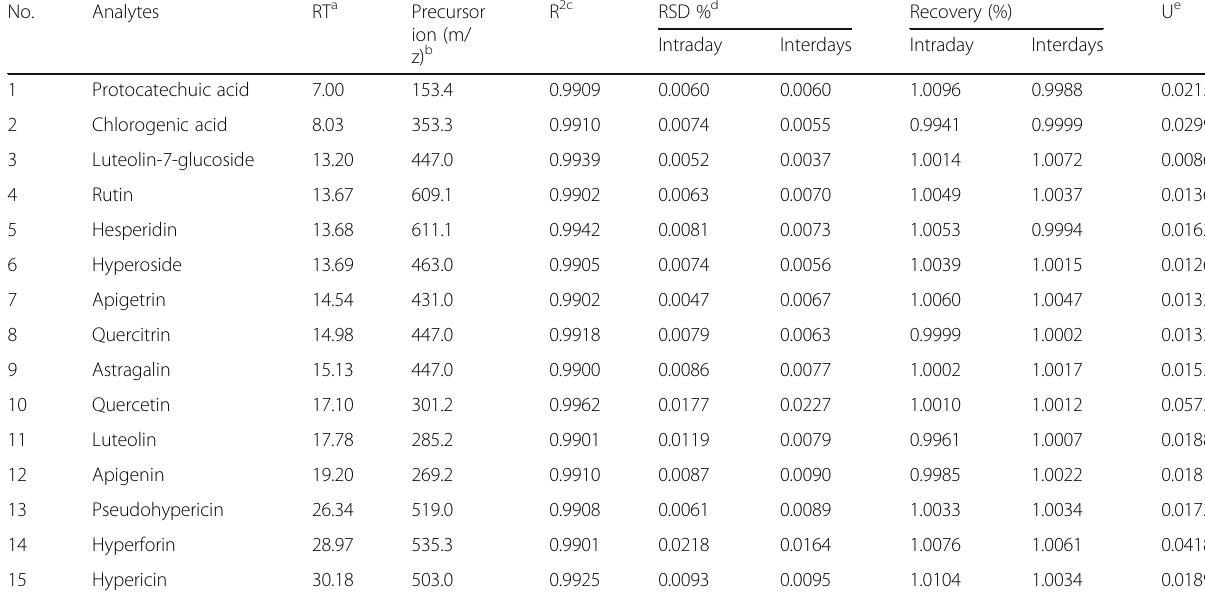
Table 3 Analytical parameters of LC-MS/MS method for the analysis of 15 phytochemicals